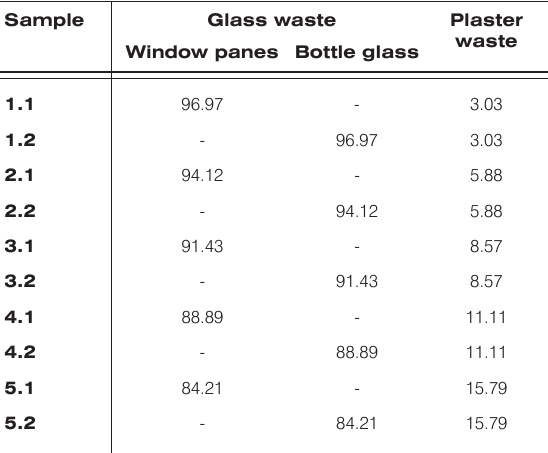
Table 2. Batch composition of the studied glass foams [wt. %].